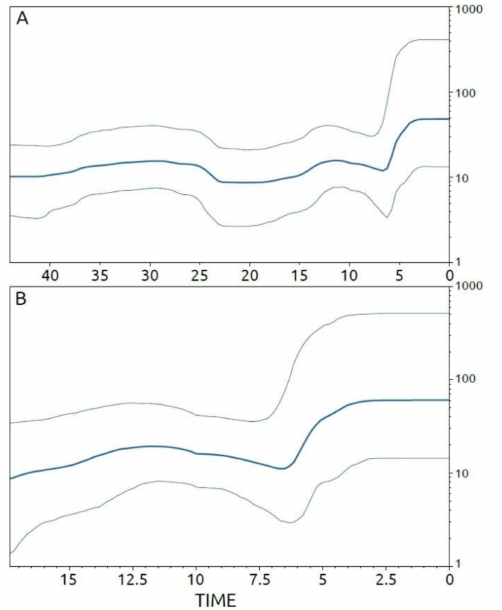
Figure 6. Bayesian skyline plots depicting the evolutionary history of ASFV on the Mediterranean island of Sardinia: whole Sardinia dataset and cluster C. The viral effective population size ( y -axis) is shown as a function of time ( x -axis), with the units expressed in years. ( A ) ASFV whole Sardinia dataset, ( B ) dataset encompassing only Sardinian sequences included in cluster C of the phylogenetic tree. The bold lines denote the median population estimates and the grey lines denote the 95% high posterior density (HPD) region.